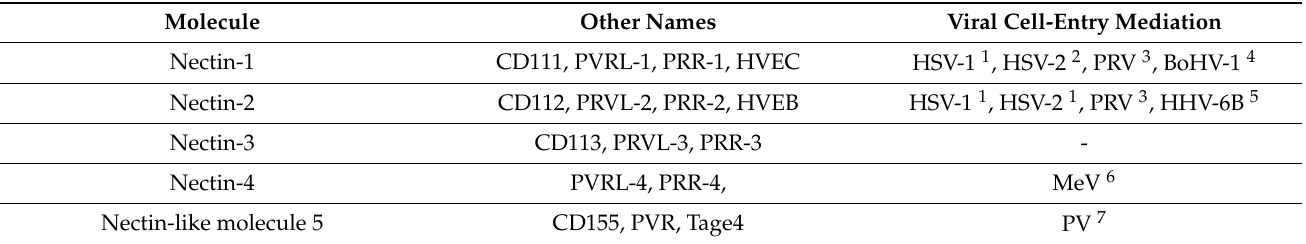
Table 1. The Nectin nomenclature and viral cell-entry mediation